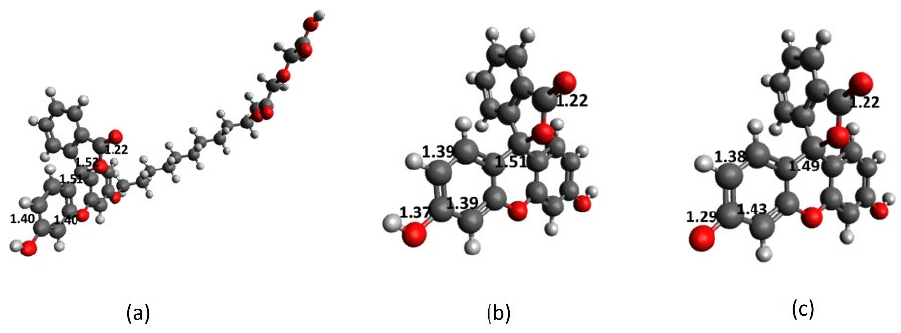
Figure 2. Full-structure optimized geometries in methanol; ( a ) 1 , ( b ) fluorescein, and ( c ) deprotonated fluorescein.